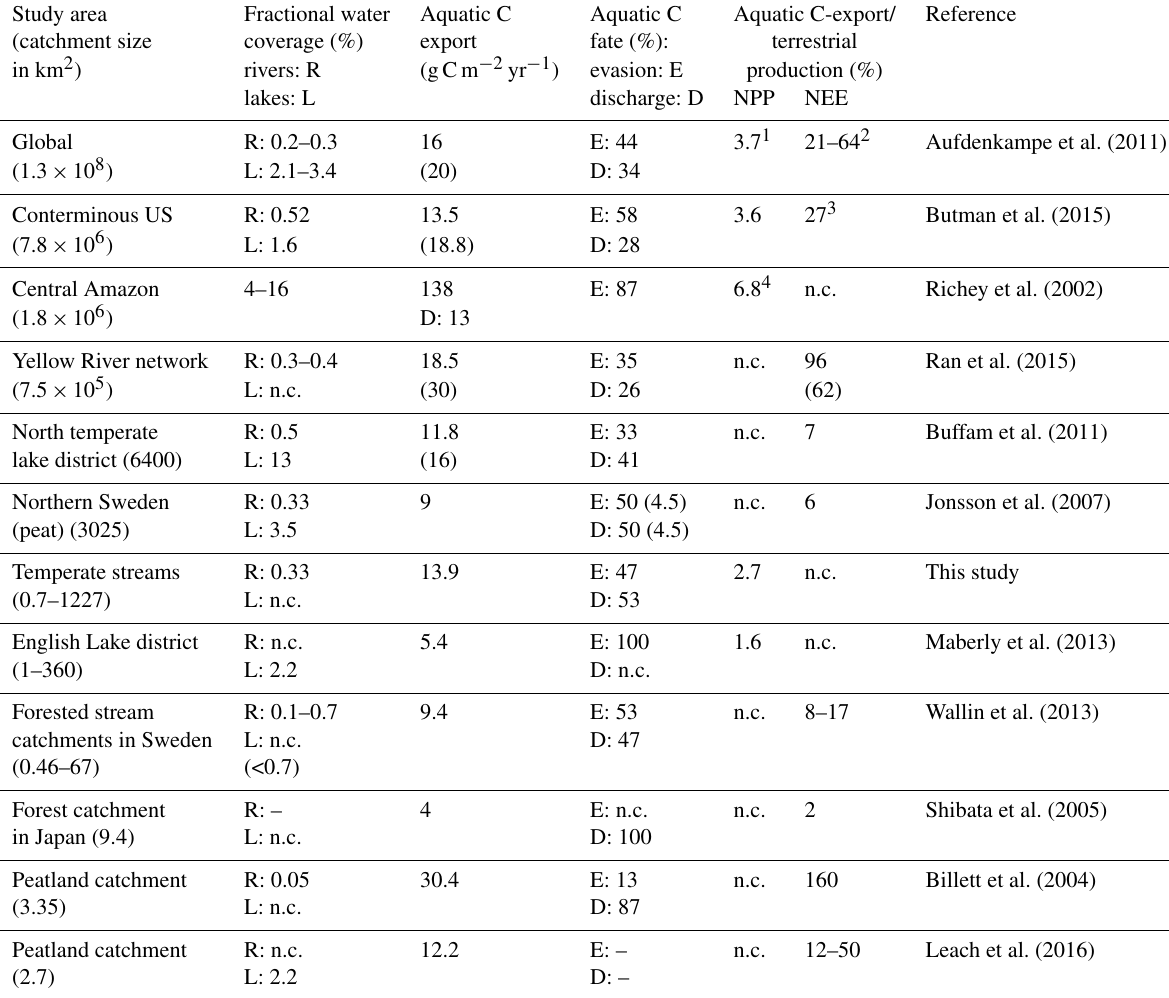
Table 3. Summary of estimates of aquatic C-export in relation to terrestrial production in the watershed across different spatial scales (spatial scale decreases from top to bottom). Aquatic C-export is the sum of C-discharge and evasion (numbers in parentheses also include the change in C storage in the aquatic systems by sedimentation) normalized by the area of the terrestrial watershed. Aquatic C fate refers to the percentage of the total exported C which is emitted to the atmosphere (evasion) and transported downstream (discharge). The missing percentage is the fraction which is stored in the aquatic systems by sedimentation (if considered). Terrestrial production is expressed as NPP or as net ecosystem exchange (NEE). n.c. indicates that this compartment/flux was not considered in the respective